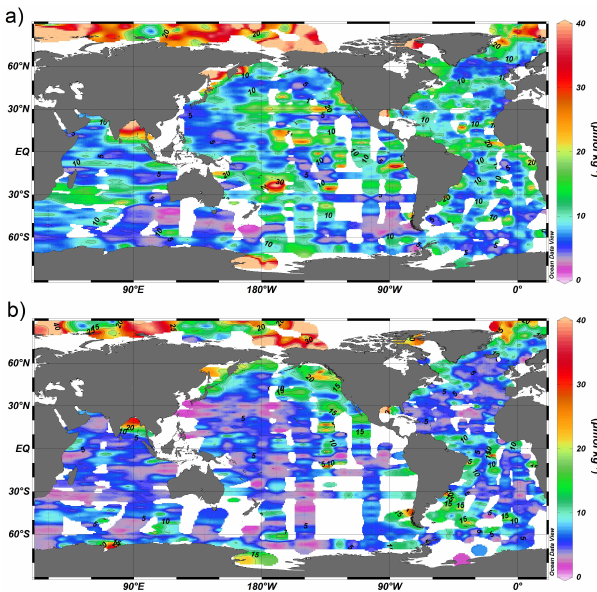
Fig. 11. Distribution of global systematic independent test absolute residual errors for (a) C T and (b) A T .